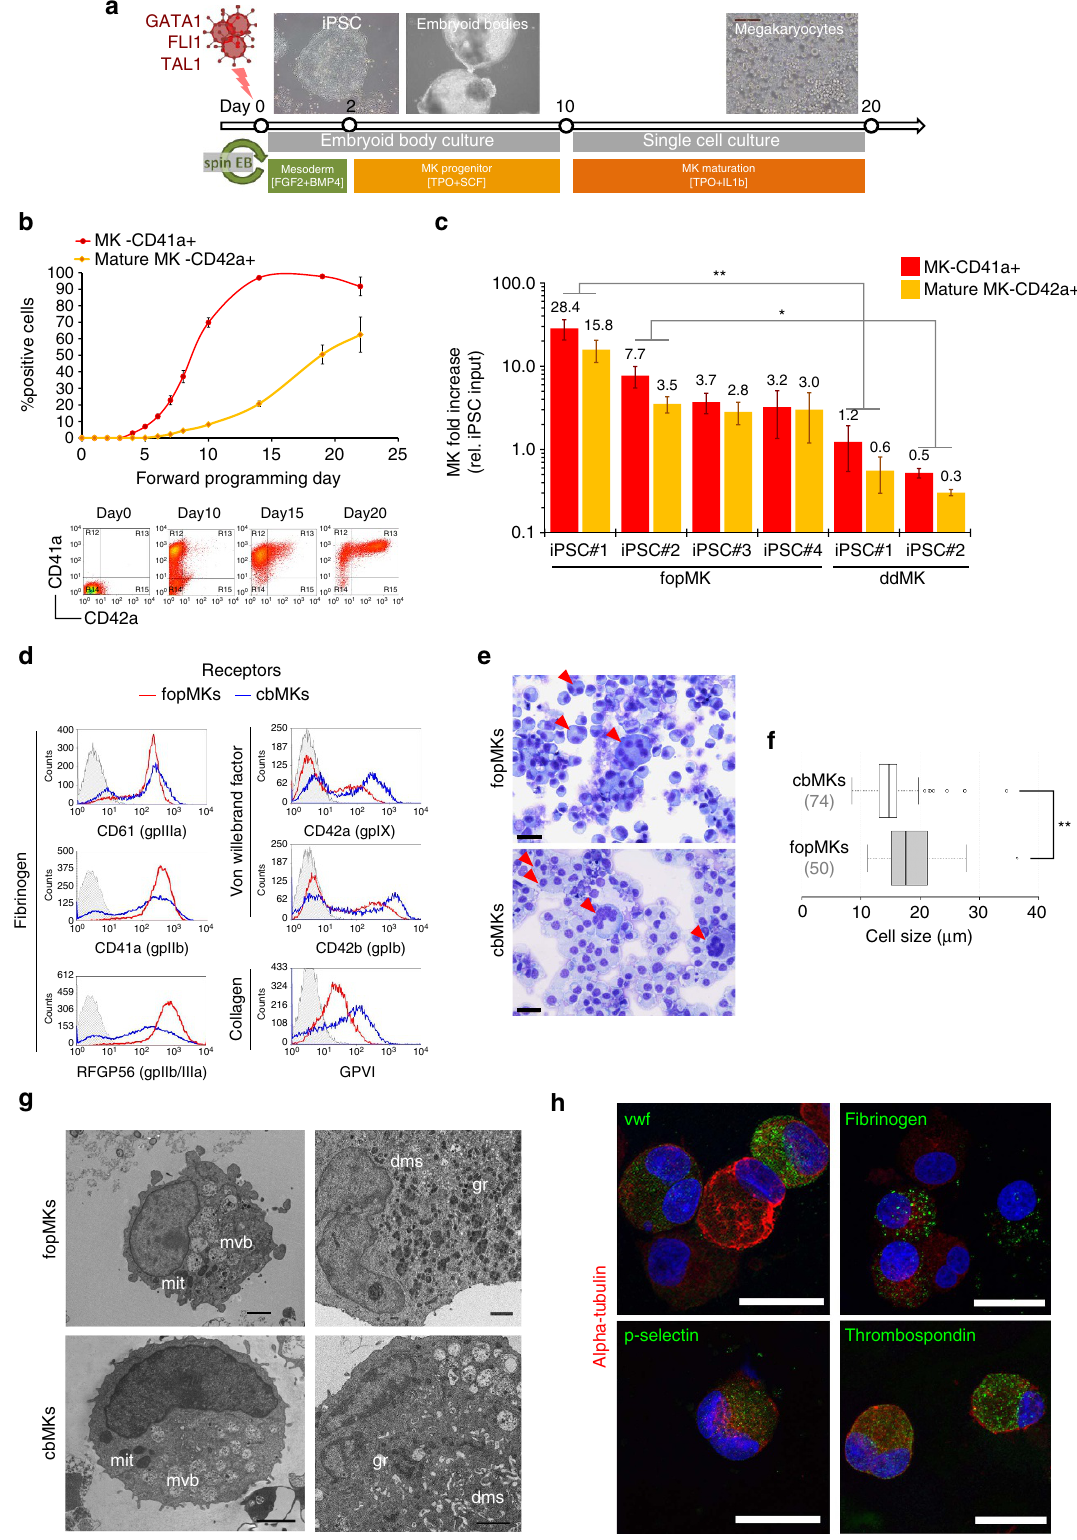
NATURE COMMUNICATIONS|7:11208|DOI: